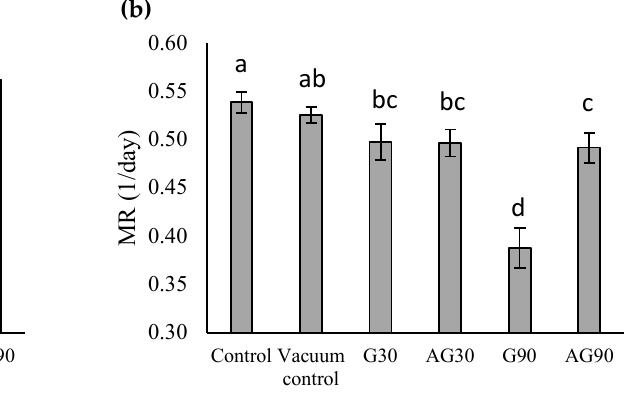
Figure 7. Final germination rate—G r ( a ), mean germination rate—MR ( b ), mean germination time— MT ( c ), and median germination time—T50 ( d ) of untreated (Control) seeds, seeds exposed to vac- uum (Vacuum control), and CP-treated wheat seeds in the glow regime for 30 (G30) or 90 s (G90), and the afterglow regime for 30 (AG30) or 90 s (AG90). Displayed values are the mean ± SE of three replications. Different letters (a–c) indicate statistically significant differences among treatments ac- cording to Duncan’s test ( p < 0.05). 2.8. α-Amylase Activity in Seeds A crucial process involved in seed germination after the imbibition of the seeds is starch decomposition, providing fuel to the seed embryo for its development and growth [15]. One of the main enzymes accountable for starch degradation is α-amylase, activated during the seed imbibition. As shown in Figure 8, seeds exposed to vacuum conditions showed significantly higher α-amylase activity than the controls. All plasma treatments, however, caused a decrease in α-amylase activity, but without a difference between glow and afterglow treatment for the same treatment time (30 s or 90 s). Thus, a common